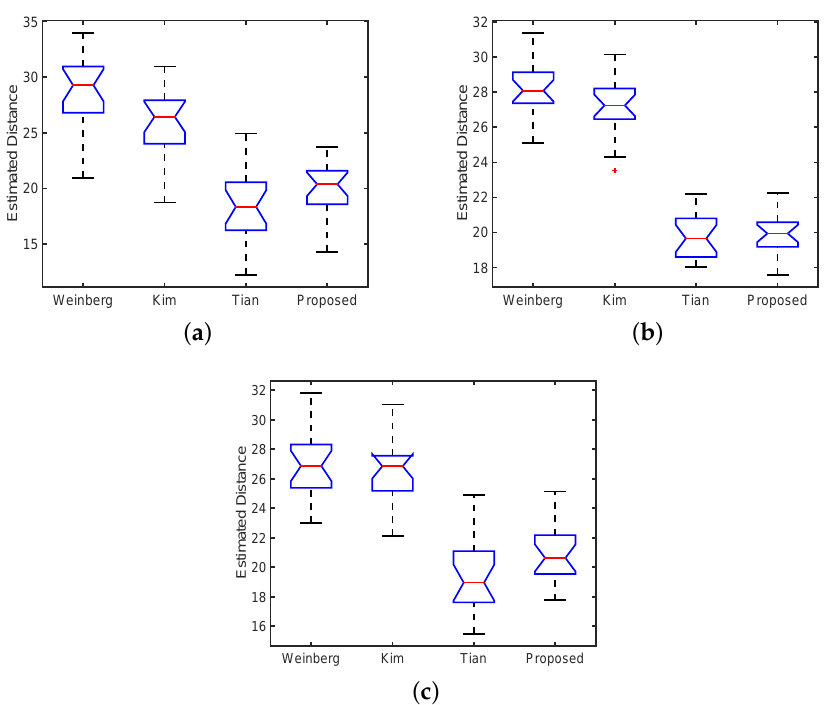
Figure 9. Comparison of the distance estimation methods. ( a ) Slow Walking; ( b ) Normal Walking; ( c ) Fast Walking.